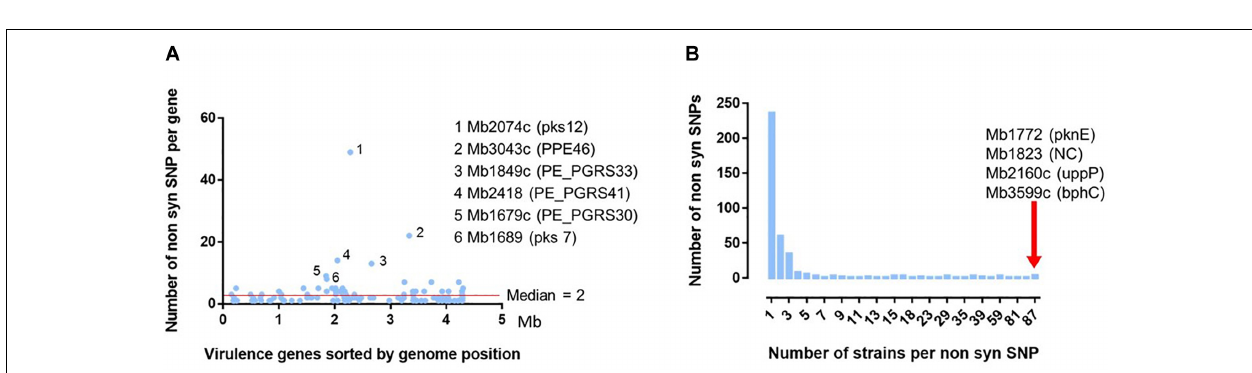
FIGURE 6 | Analysis of the 392 non-synonymous SNP detected in 131 virulence genes on the 87 French M. bovis isolates. (A) Distribution of the 392 non-synomymous SNPs detected in the French isolates in comparison to the reference genome of M. bovis AF2122/97. The position of the detected nsSNPs was ordered according the genomic location of the 131 virulence genes (detailed in Supplementary Table S4 ). The six genes with the non-synonymous SNP most frequently detected are indicated with their locus tag and their acronym (in brackets). (B) Distribution of number of strains per non-synonymous SNP detected on 131 virulence genes. Most of the 392 ns SNPs are detected on one unique strain. The red arrow indicates four non-synonymous SNPs, in four different genes indicated by their locus name and acronym, present in the totality of the 87 French field isolates compared to the reference genome